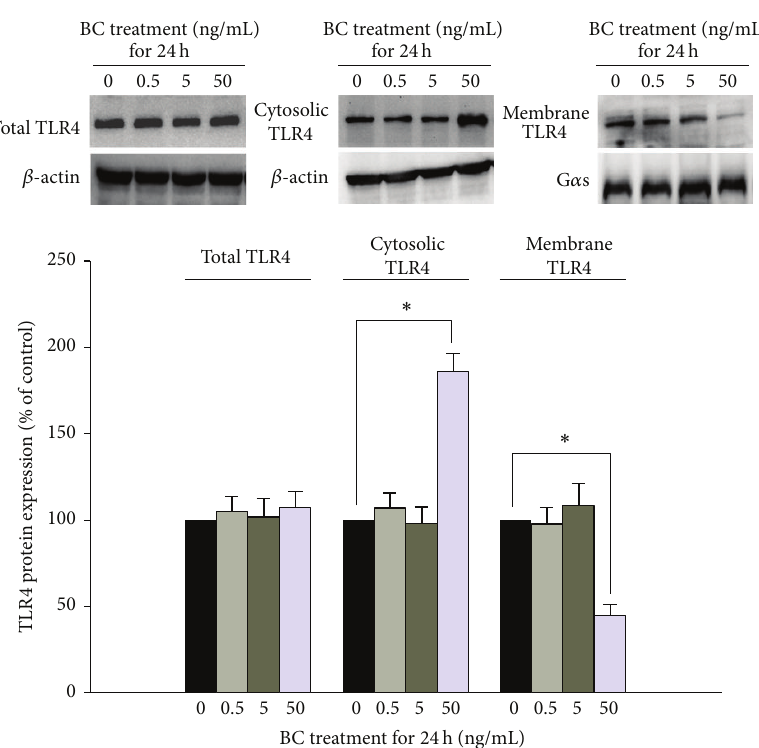
Figure 3: Alteration of subcellular distribution of TLR4 protein by bone component (BC) exposure in U937 cells. U937 cells were treated with 0.5–50 ng/mL BC for 24 hr. Total protein, cytoplasmic portion, and membranous portion of TLR4 in U937 cells were detected using western blot analysis. The 𝛽 -actin and G 𝛼 s were used as an internal control. The bar diagram represents quantification of TLR4 expression in U937 cells. Data represent the results of 3 independent experiments (mean ± SEM; ∗ 𝑃 < 0.05 between